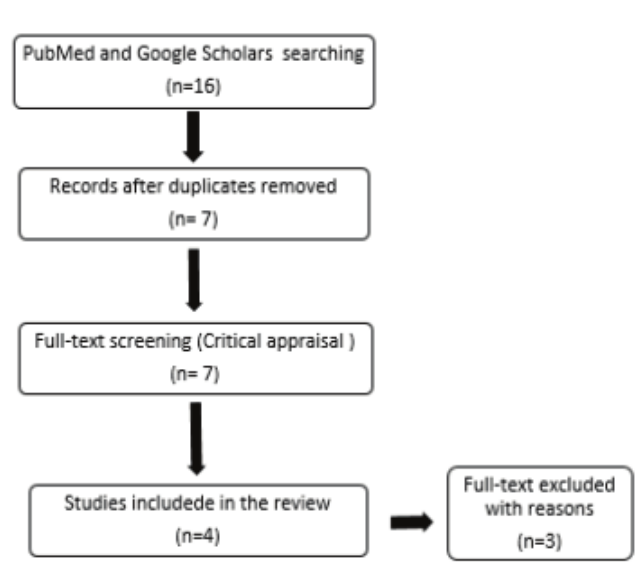
Figure 2: Flow-gram of search and selection of